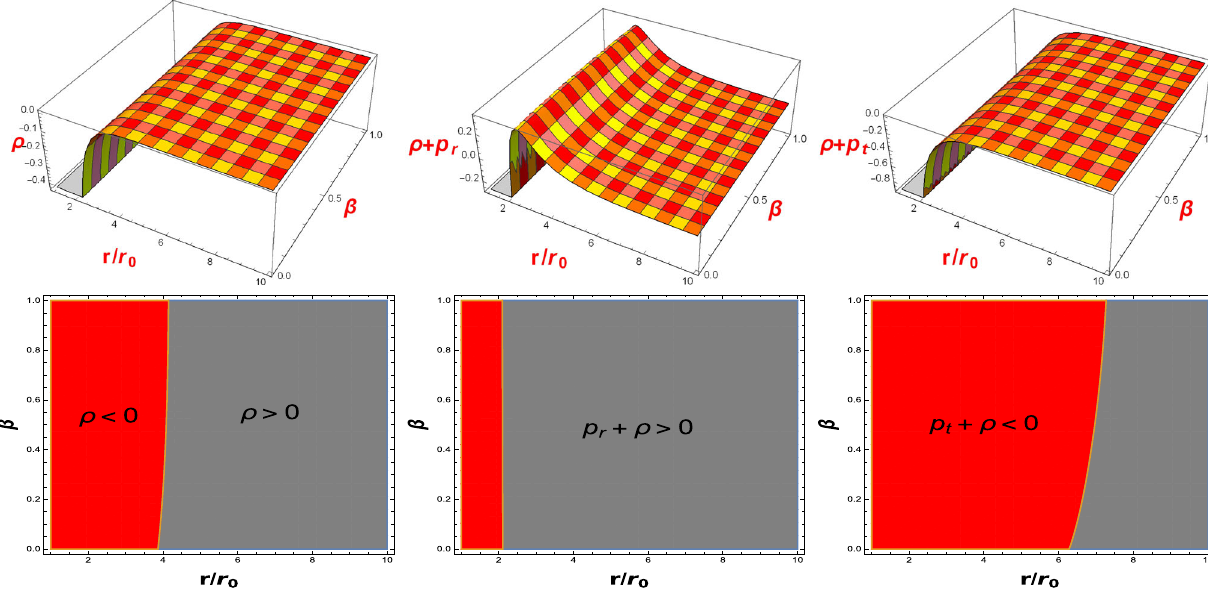
Fig. 6 Exponential shape function (cid:6)( r ) = r 0 Log [ 1 + r ] ρ + p t . 2nd row shows the feasible regions, where